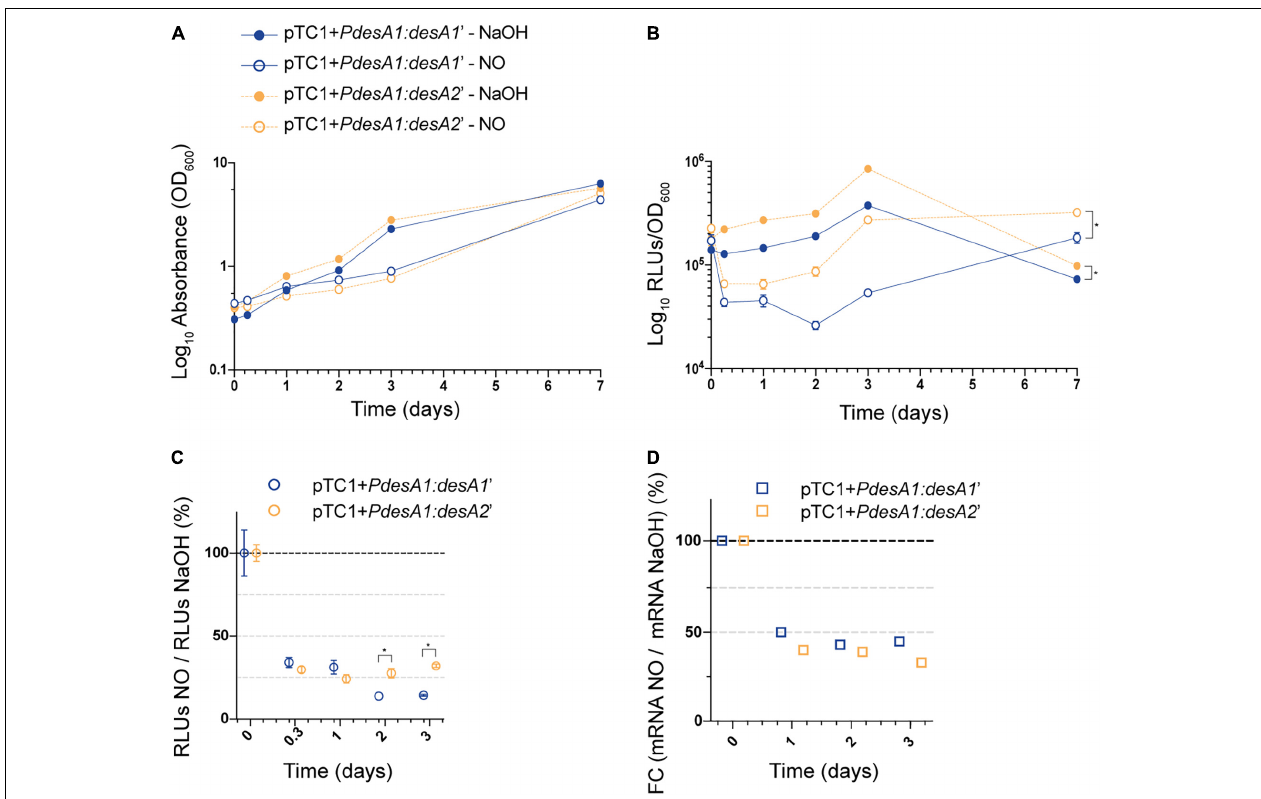
FIGURE 4 | Growth and translation kinetics of the leaderless and Shine–Dalgarno reporters during nitric oxide (NO) stress. Cultures of M. tuberculosis carrying integrative vectors pTC1 + PdesA1 : desA1’ [Shine-Dalgarno (SD), blue] and pTC1 + PdesA1 : desA2 ’ [leaderless (L), orange] were grown to mid-exponential phase (time 0) when cells were either challenged with 0.25 mM NO or the vehicle NaOH as control. For each timepoint and reporter at least three independent transformants were used and measurements were done in triplicate; the mean and standard deviation are presented. (A) OD 600 was monitored for 7 days. (B) Luminescence, given as relative light units (RLUs) corrected by growth. Asterisks denote statistically significant differences between pTC1 + PdesA1 : desA1’ and pTC1 + PdesA1 : desA2 ’ reporters for all timepoints in each condition (multiple t -tests, p < 0.03). (C) The RLU value during NO challenge was normalized against the corresponding RLU NaOH value. The value obtained at time 0 was considered as 100% translation efficiency. Statistically significant differences are indicated with an asterisk (multiple t -tests, p < 0.002). (D) Quantification of mRNA levels by real-time PCR. 16S rRNA was used as the internal control. Fold changes (FC) are relative to the NaOH corresponding control and the value obtained at time 0 was considered as 100% transcription